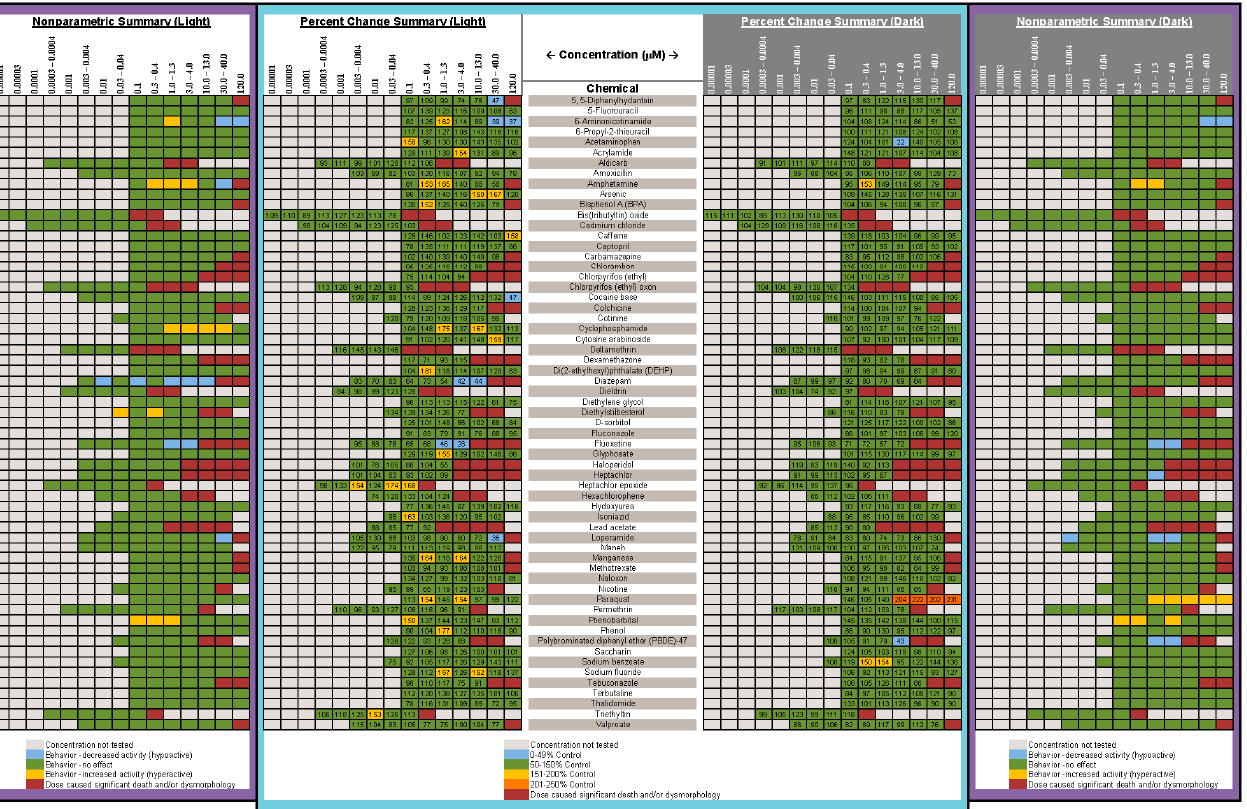
Figure 6. Comparison of Nonparametric Statistical Results and Percent Change Calculations. Comparison of the nonparametric statistical results (from Figure 3) and percent change calculations showing the degree of change in each concentration group compared to the controls. The middle column lists the chemical name, the outside columns show the nonparametric results for the Light and Dark periods, with the percent change columns next to them. Chemical concentrations are listed at the top of each column. Colored shading represents the following: light gray = concentration not tested; blue = decrease in activity; green = no effect; yellow = increase in activity; red = developmental toxicity. The percent change value is indicated in each cell and the data are color coded by 50% increments.